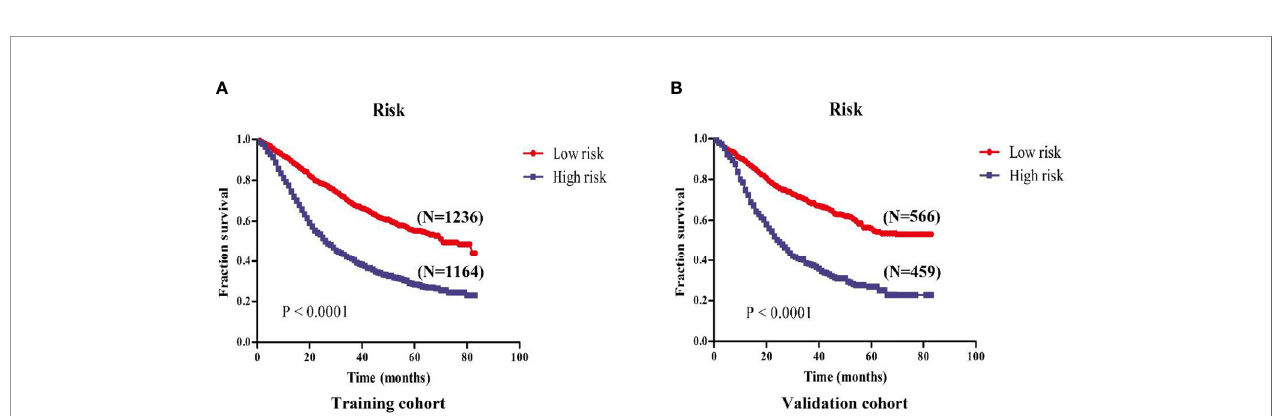
FIGURE 7 | Calibration plot of the nomogram for assessing the survival of GEJ cancer without distant metastasis in the training and validation cohorts. (A) Training cohort; (B) Validation cohort.